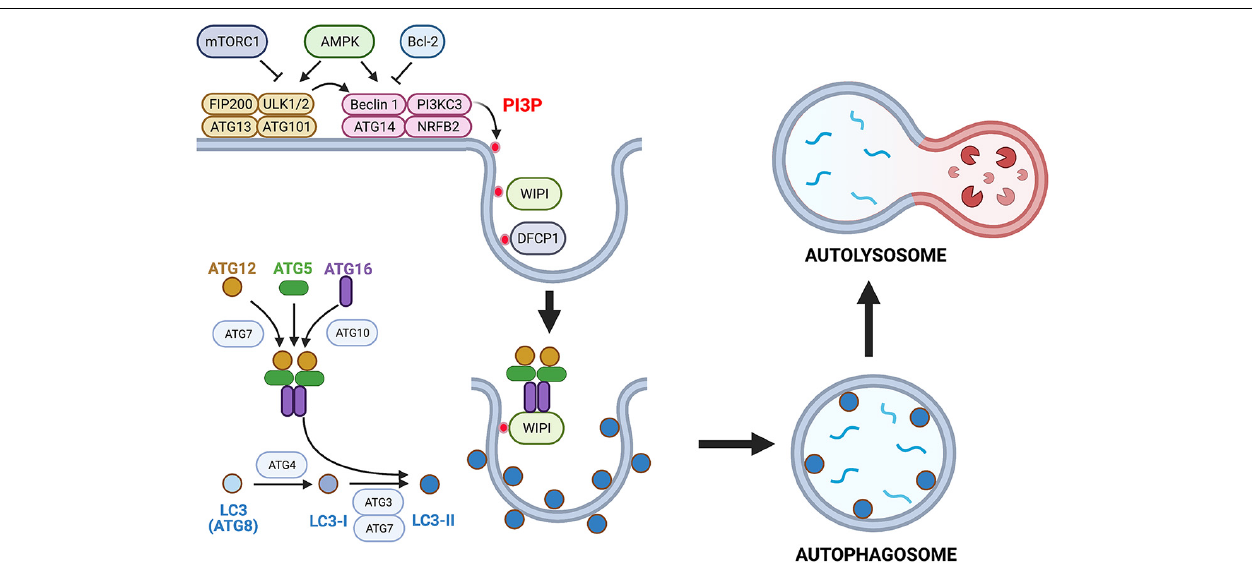
FIGURE 1 | Overview of the autophagy pathway. Autophagy is a constitutive and well-conserved process of lysosomal degradation. Autophagy is triggered by activation of ULK1 that forms a complex with ATG13, ATG101, and FIP200. ULK1 is under control of AMPK and mechanistic target of rapamycin complex 1 (mTORC1). A decrease in energy status activates ULK1 via AMPK leading to autophagy stimulation, whereas nutrient-rich conditions inhibit ULK1 via mTORC1. Membrane-associated ULK1 complex recruits and activates the PI3KC3 complex that also contains Beclin 1, ATG14, nuclear receptor binding factor 2 (NRBF2), as well as p150 and activating molecule in BECN1-regulated autophagy protein 1 (AMBRA1) (not shown). Bcl-2 inhibits pro-autophagic effect of Beclin 1. Activation of PI3KC3 complex causes local production of PI3P that recruits PI3P-binding proteins double FYVE domain-containing protein 1 (DFCP1) and WD-repeat protein interacting with phosphoinositides (WIPI). These scaffold proteins mediate membrane remodeling. Active PI3KC3 complex and WIPI promote expansion of isolation membrane through recruitment of ATG proteins. These proteins function as two ubiquitin-like conjugation systems: (i) ATG7 and ATG10 that conjugate ATG5 to ATG12 and ATG16. (ii) ATG3 and ATG7 together with ATG12–ATG5–ATG16 complex induce lipidation (phosphatidylethanolamine conjugation) of LC3 (ATG8). Lipidated LC3 (LC3-II) binds to several autophagy receptors promoting substrate uptake. Sequestration of the cargo by autophagosomes is followed by fusion with lysosomes resulting in formation of an autolysosome and lysosomal degradation of the cargo. This figure is a simplified overview of some of central components of autophagy pathway in mammalian cells. Figure was generated using